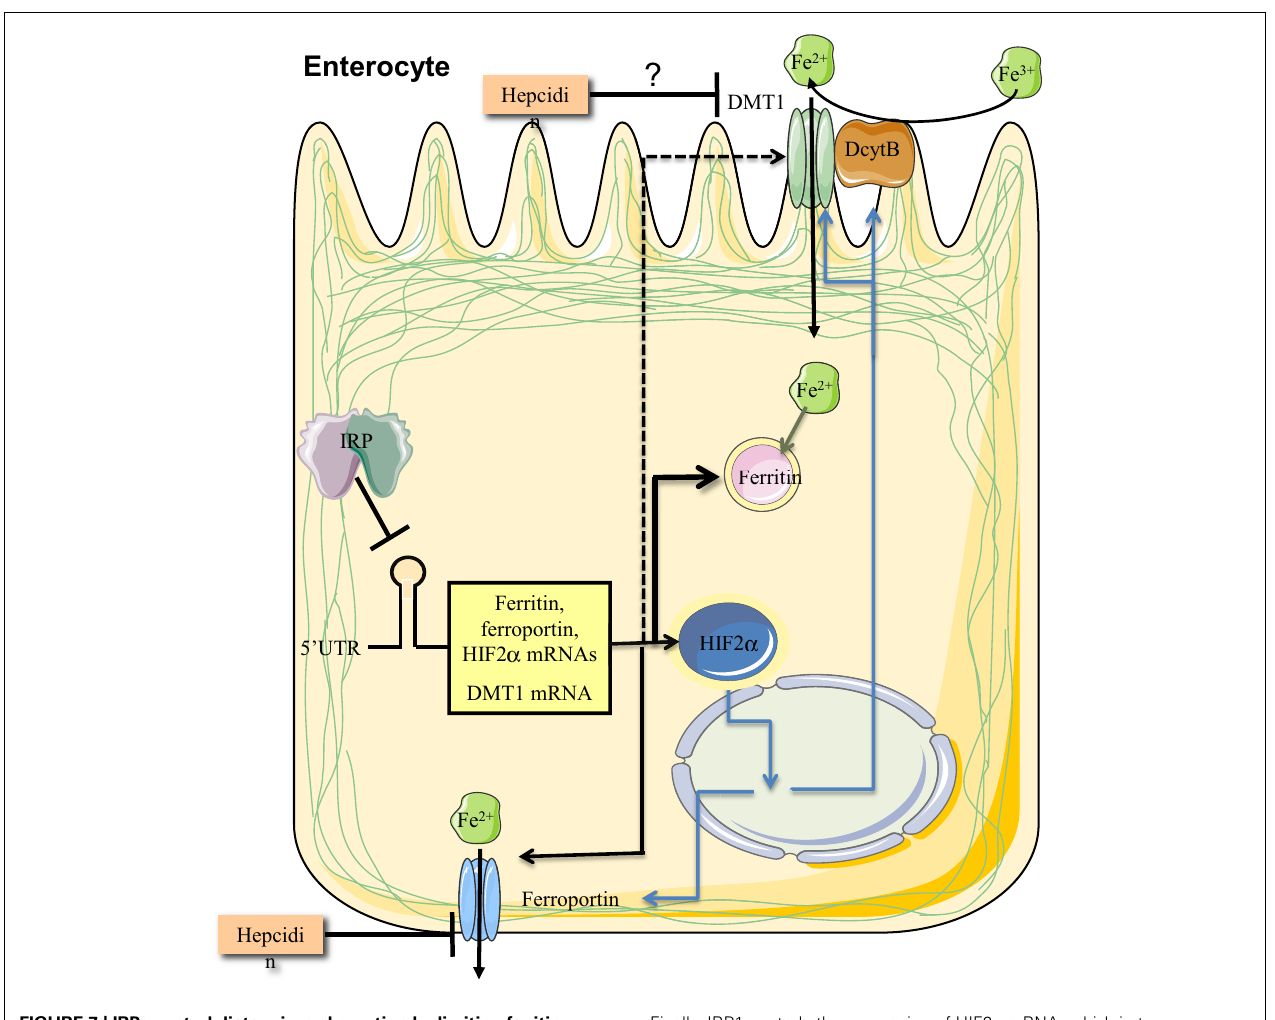
Finally, IRP1 controls the expression of HIF2 α mRNA, which in turn transcriptionally induces, among other targets, the iron transporters ferroportin and DMT1, and the ferrireductase Dcytb. Ferroportin and possibly also DMT1 are negatively regulated by hepcidin at the level of protein